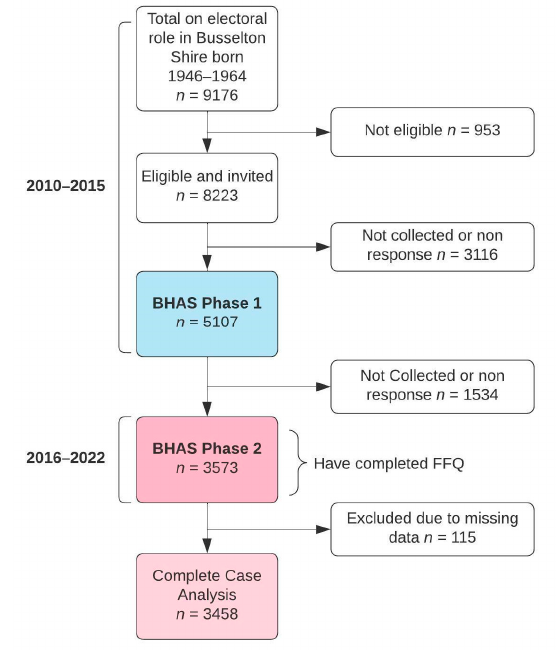
Figure 1. Participant flow chart.